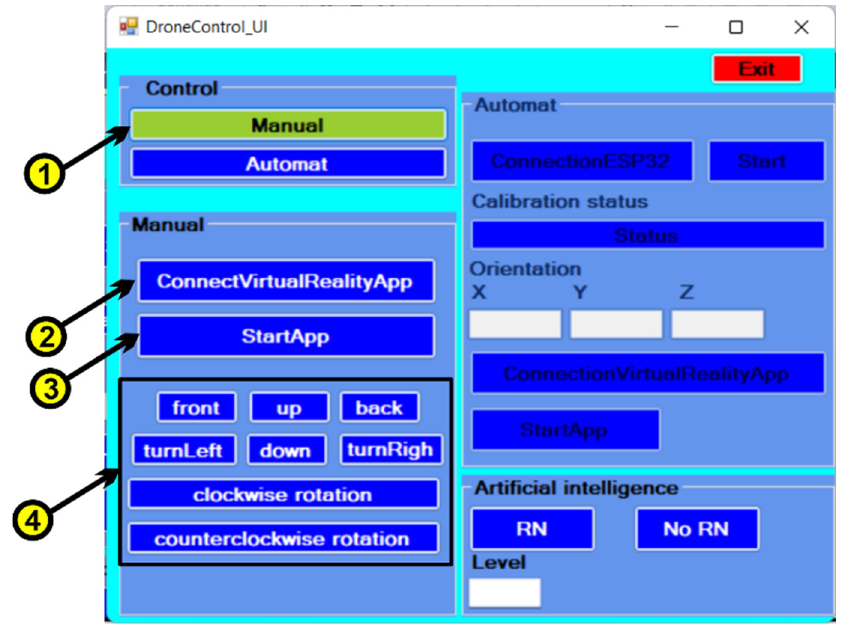
Figure 12. User Interface—automatic control. Figure 11. User Interface—automatic control.